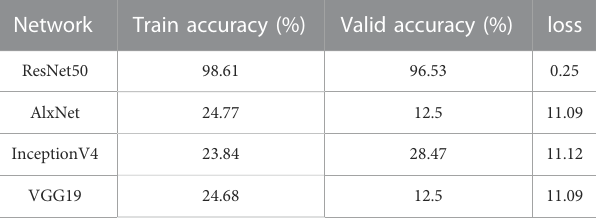
TABLE 6 Other typical computer vision network pre-training results.